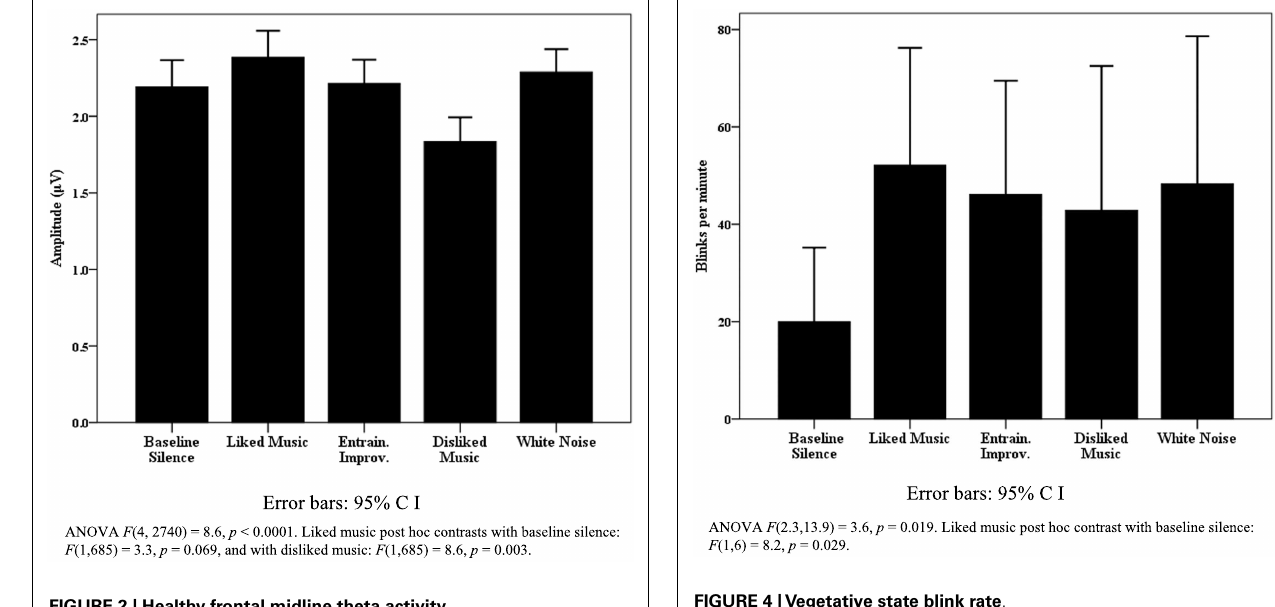
FIGURE 2 | Healthy frontal midline theta activity .